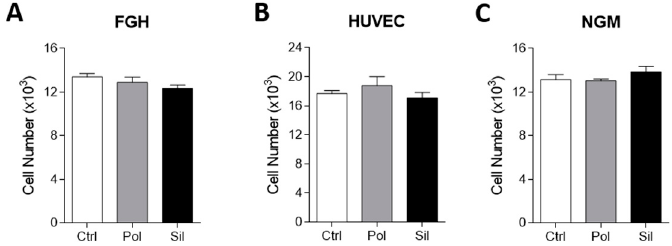
Figure 4. Nanoparticles e ff ects on non-tumor cytotoxicity. FGH (human fibroblast cell line), HUVEC (Human umbilical vein endothelial cell line) and NGM (human melanocyte cell line derived from blue nevus cell line cells were incubated with polymeric (pol) or silica (sil) nanoparticles (20 µ g / mL) for 24 hs. Cytotoxicity was evaluated using the MTT assay. ( A ). FGH ( B ). HUVEC ( C ). NGM. Results are presented as the mean ± SD calculated from three individual experiments (* p < 0.05).